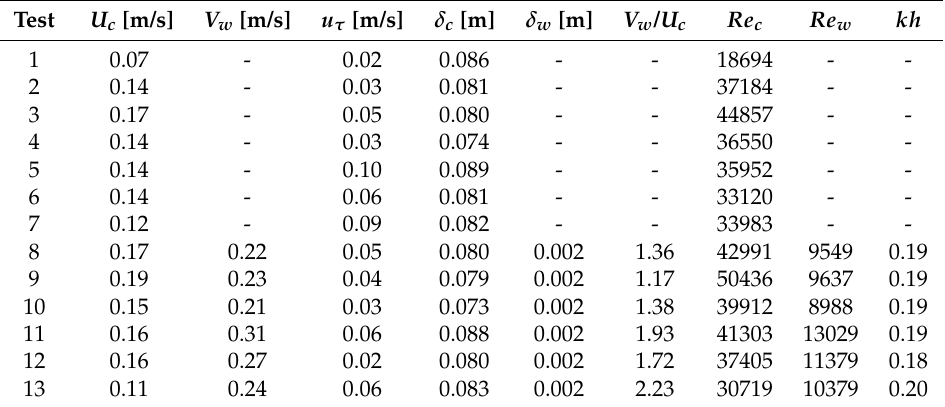
Table 2. Hydrodynamic quantities and parameters for all tests: current freestream velocity U c , wave orbital velocity V w , shear velocity u τ , current boundary layer thickness δ c , wave boundary layer thickness and relative water depth kh